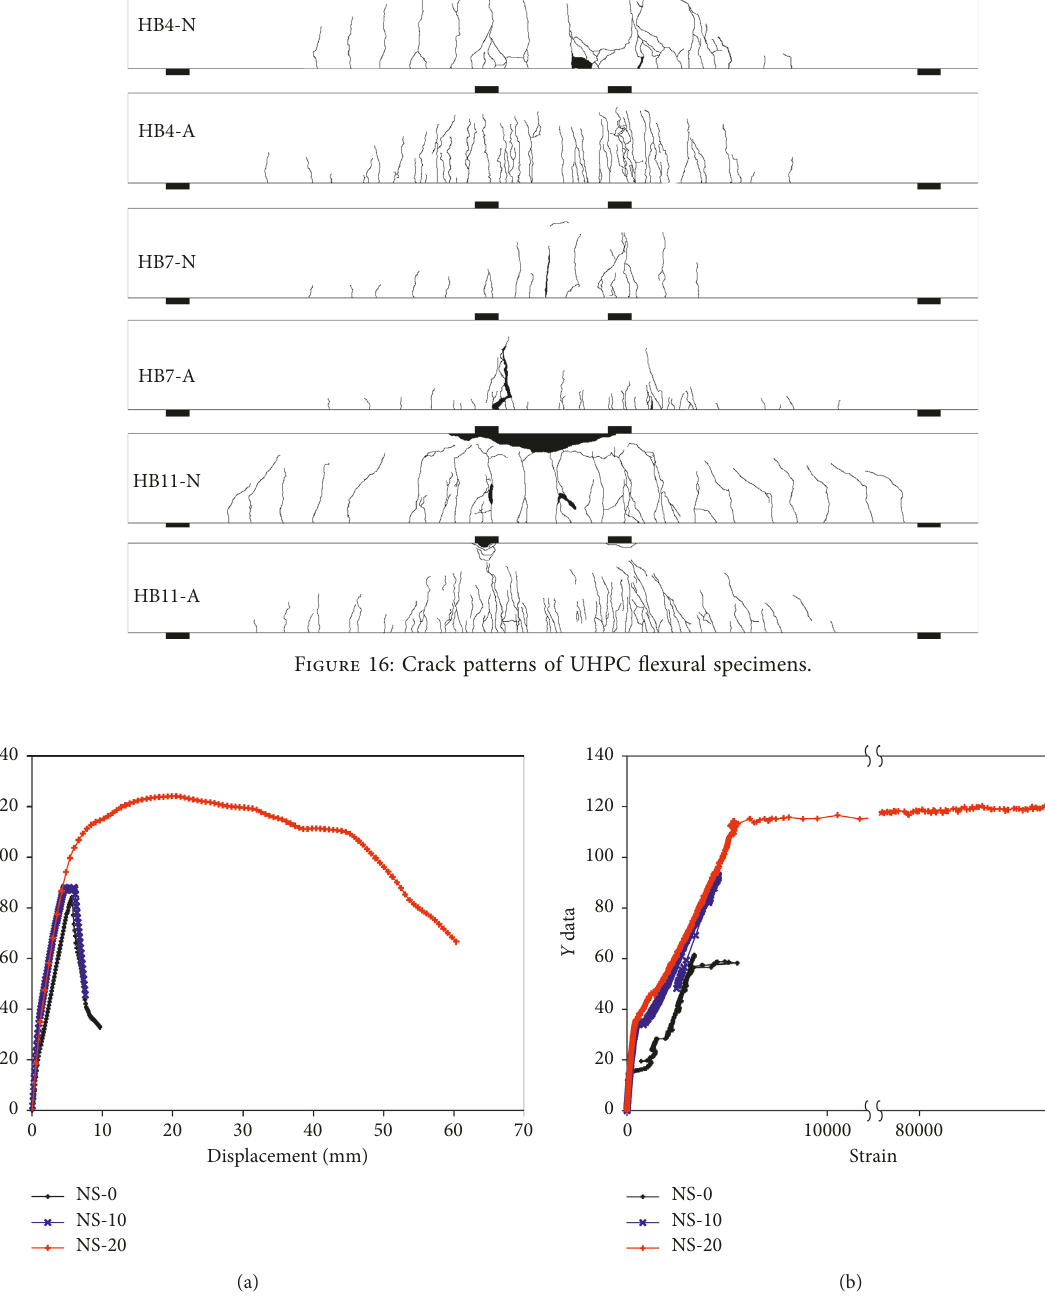
Figure 17: Load-displacement and load-steel strain curve of NSC specimens. Table 17: Shear load of NSC